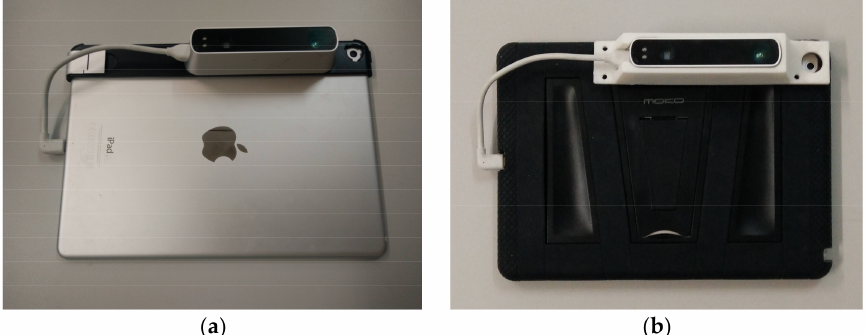
Figure 2. Hardware used in the SIRAE project consisting of an iPad and a Structure Sensor ( a ); and the devices protected with cases ( b